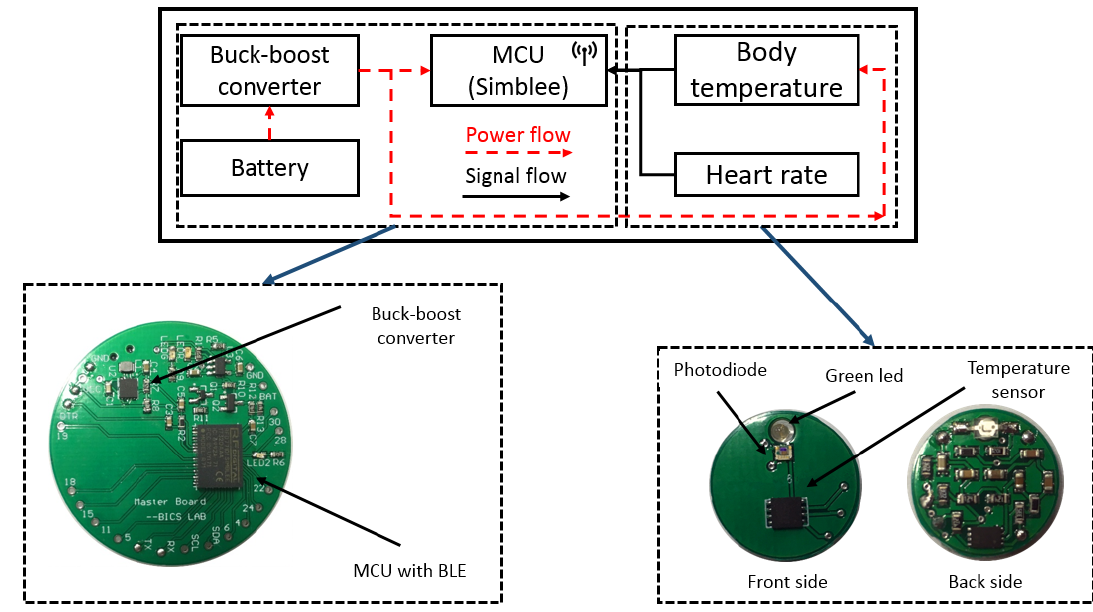
Figure 6. The Health node